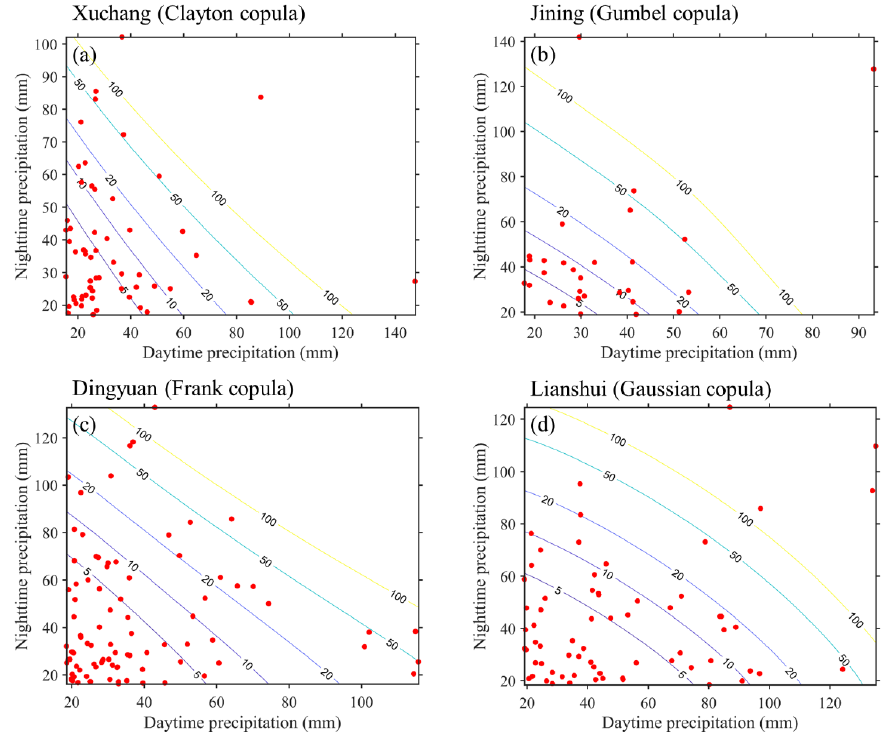
Figure 19. Joint return periods (years, contour lines) of daytime and nighttime precipitation under CEDNP conditions based on the copula method. The solid red dots denote CEDNP events. ( a ) Xuchang, ( b ) Jining, ( c ) Dingyuan, and ( d ) Lianshui are located in the western, northern, southern, and eastern parts of the HRB, respectively.